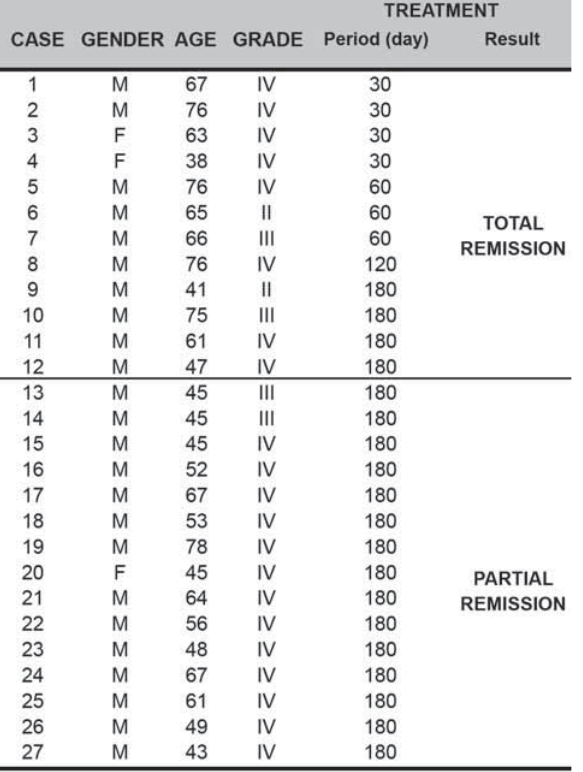
Figure 4- Gender, age and grade of actinic cheilitis of the 27 patients who completed the therapy, as well as, period and results obtained with the topical application of